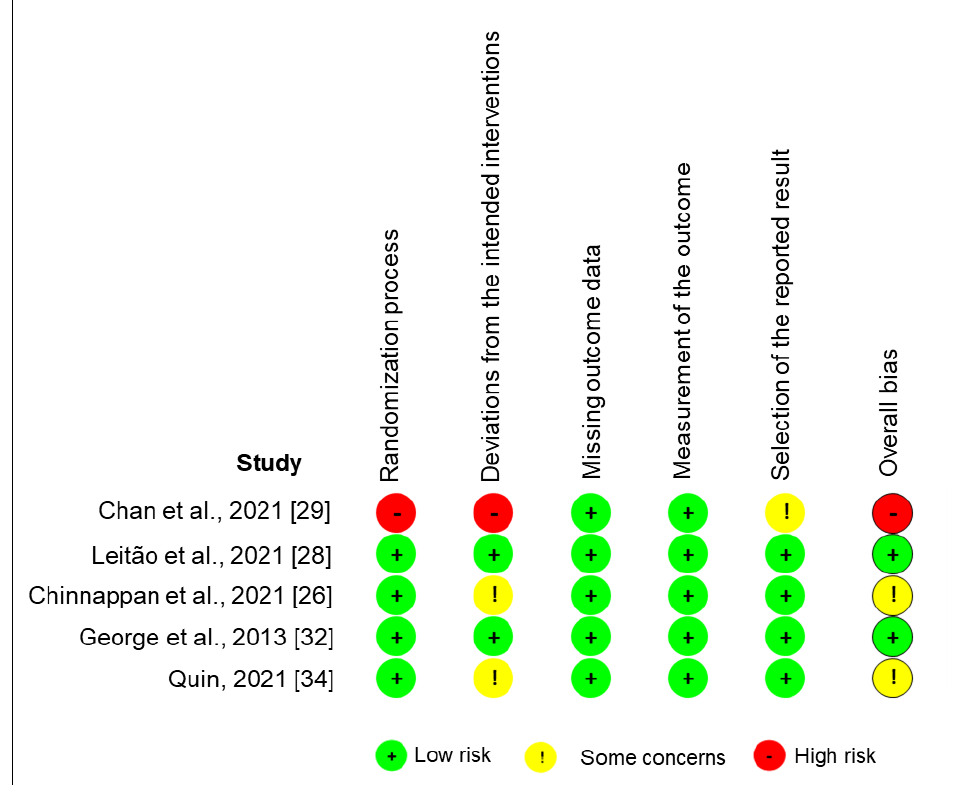
Figure 2. Assessment of quality and risk of bias of the studies included in the meta-analysis, using the version 2 of the Cochrane risk-of-bias tool for randomized trials [23]. Studies included: Chan et al., 2021 [29]; Leitão et al., 2021 [28]; Chinnappan et al., 2021 [26]; George et al., 2013 [32]; Quin, 2021 [34].